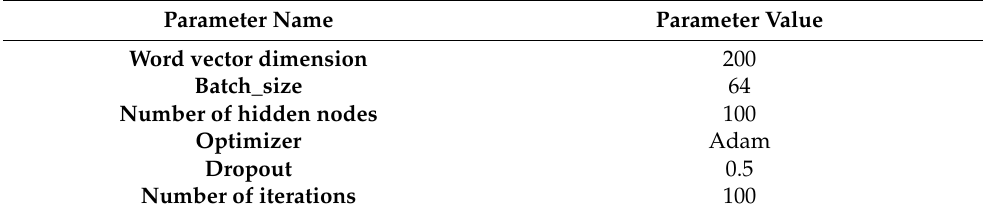
Table 1. BiSGRU-GA Model parameter setting.